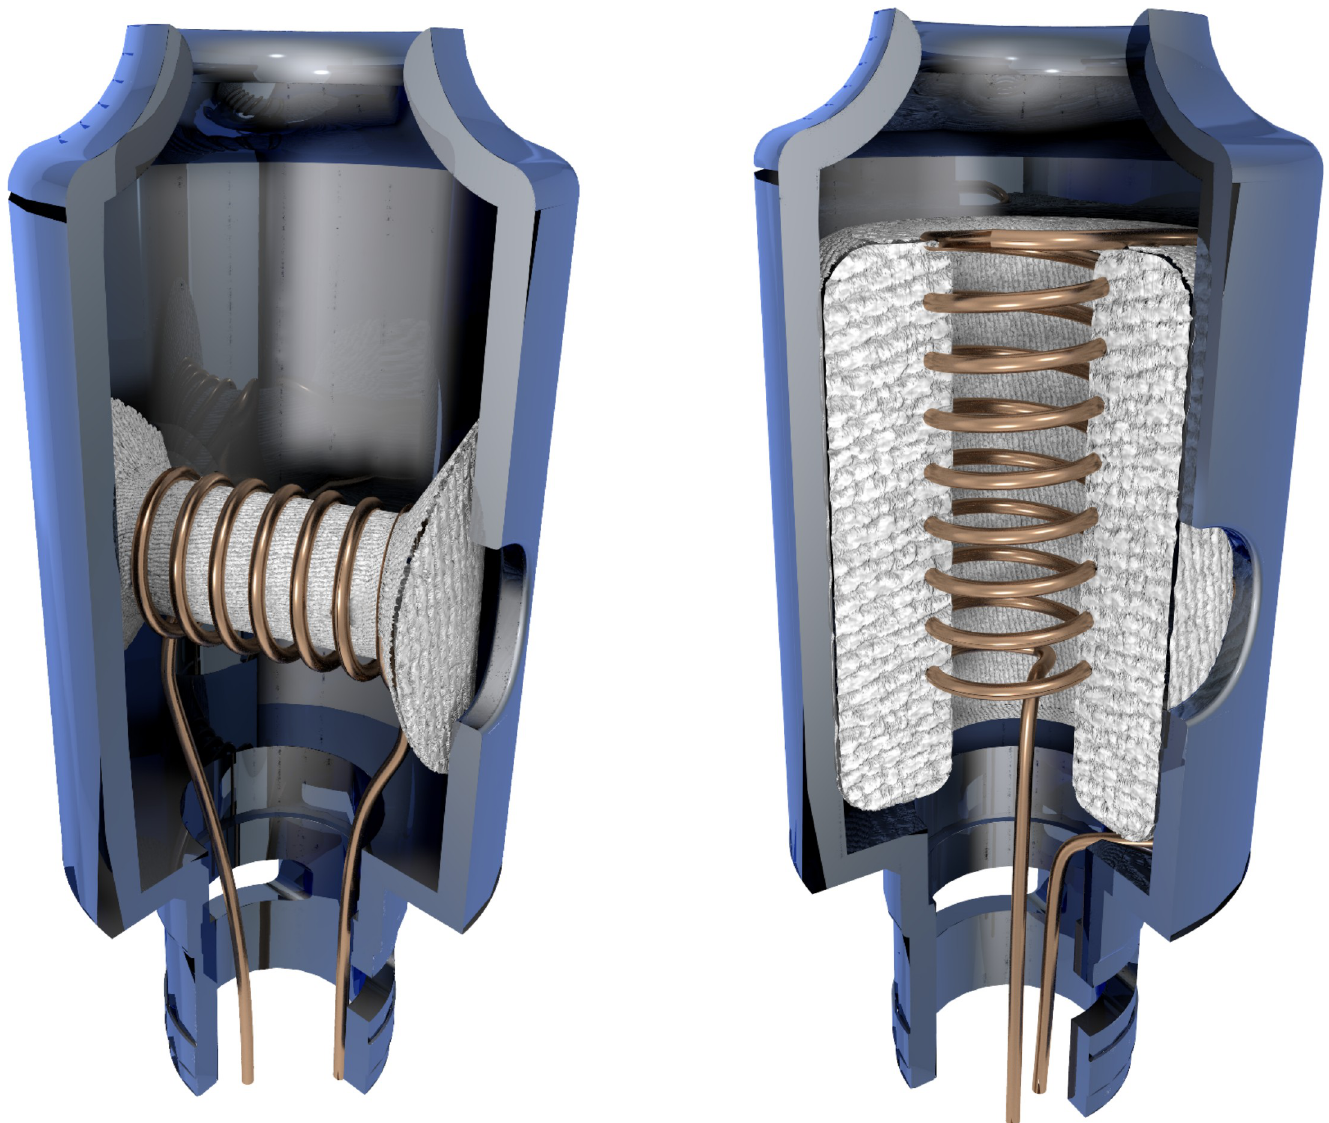
Fig 1. Depiction of horizontal (left) and vertical (right) coil orientations. The vertical coil has a surrounding